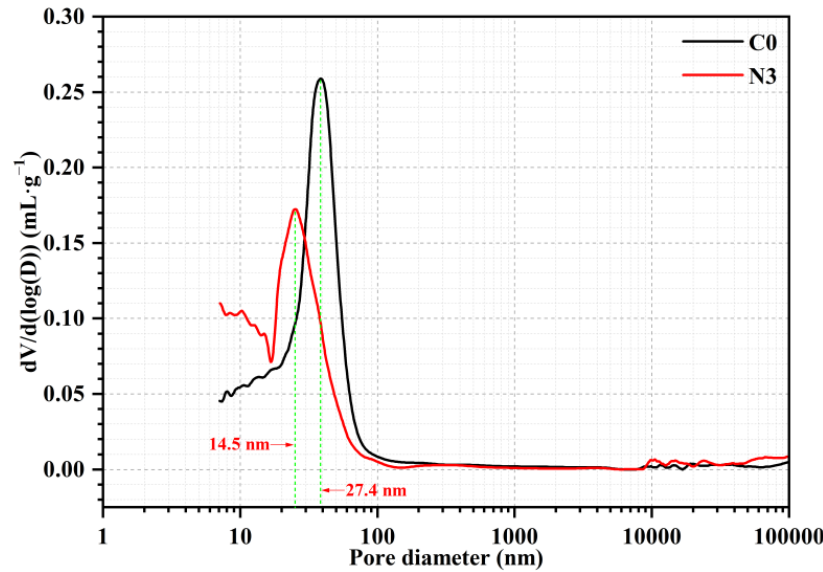
Figure 11. MIP results of 28 d cured samples C0 and N3.